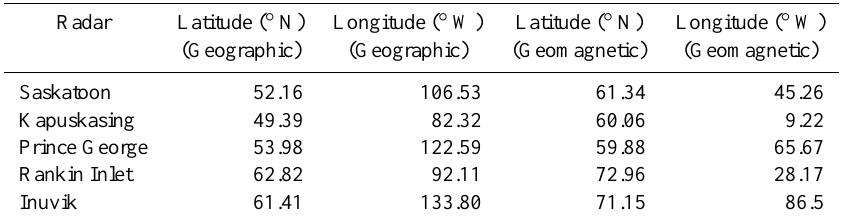
Radar Latitude ( ◦ N) Longitude ( ◦ W) Latitude ( ◦ N) Longitude ( ◦ W) (Geographic)